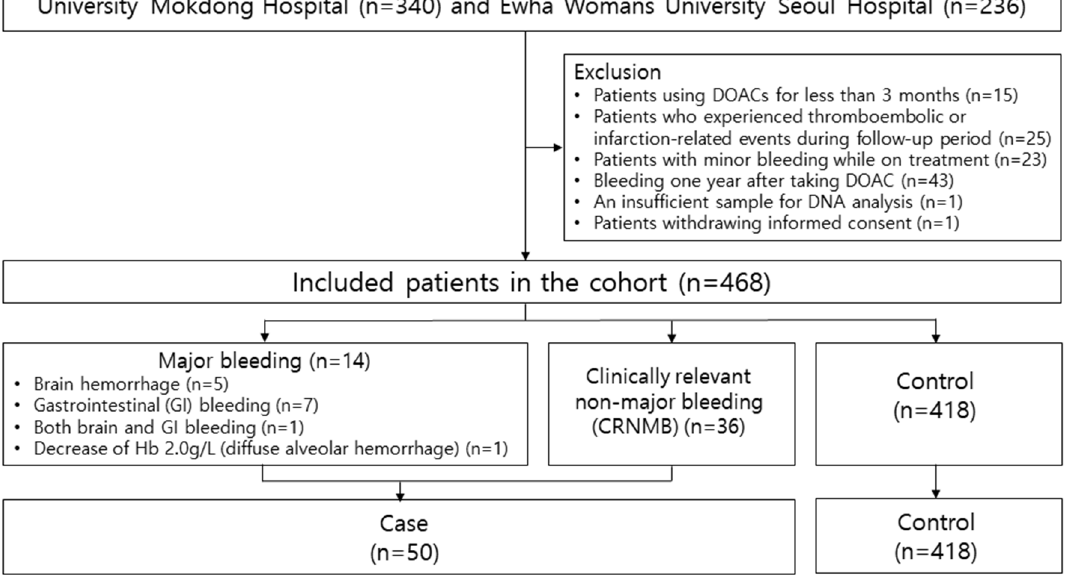
Table 1. Baseline characteristics of patients included in this study.